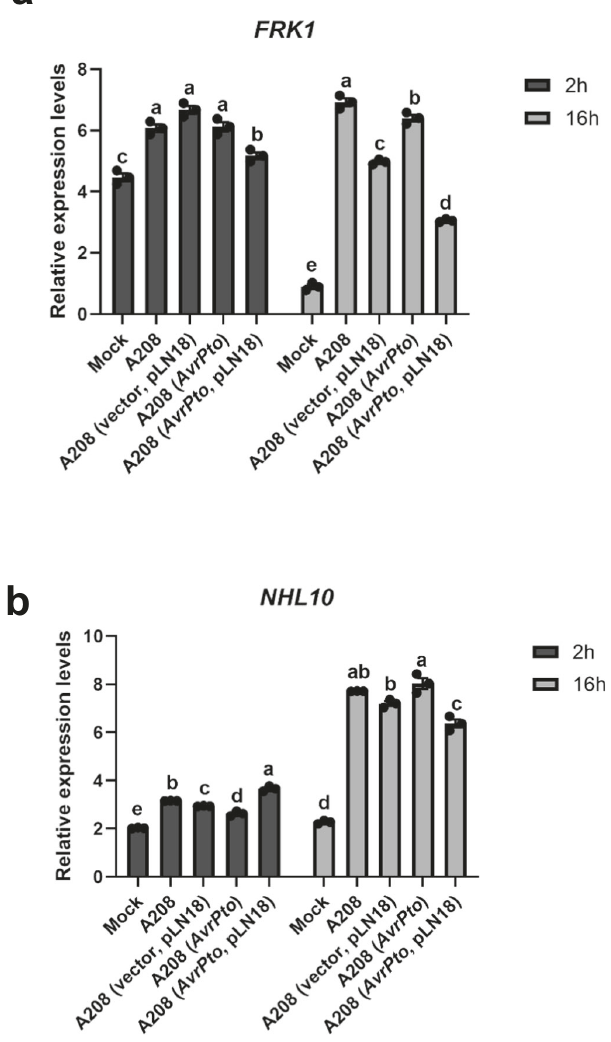
Fig. 6 Engineered A. tumefaciens strains expressing a T3SS and AvrPto reduce expression of Arabidopsis defense genes. a , b Relative expression levels of PTI marker genes. Roots of Arabidopsis plants were infected with tumorigenic A. tumefaciens strain A208 (A 600 = 1.0) expressing AvrPto in combination with and without pLN18. Mock infection (ABM-MS medium), A208, and A208 (vector, pLN18) were included as negative controls. Expression levels of a FRK1 , and b NHL10 were determined using 2 - ΔΔ CT method with the UBQ10 gene as a housekeeping control. Data presented are mean ± standard error of three replicates. Bars with different letters are signi fi cantly different based on Tukey ’ s post-hoc one-way ANOVA analysis (one-sided) ( p < 0.05). Brown-Forsythe test was done to test for variance ( p = 0.9965 for FRK1 2 h, 0.4600 for FRK1 16 h, 0.1414 for NHL10 2 h, 0.2042 for NHL10 16 h). Experiments were repeated three times with similar results. Source data are provided as a Source Data fi results indicate that engineered A. tumefaciens expressing a T3SS can also be used to deliver plant proteins to enhance AMT.